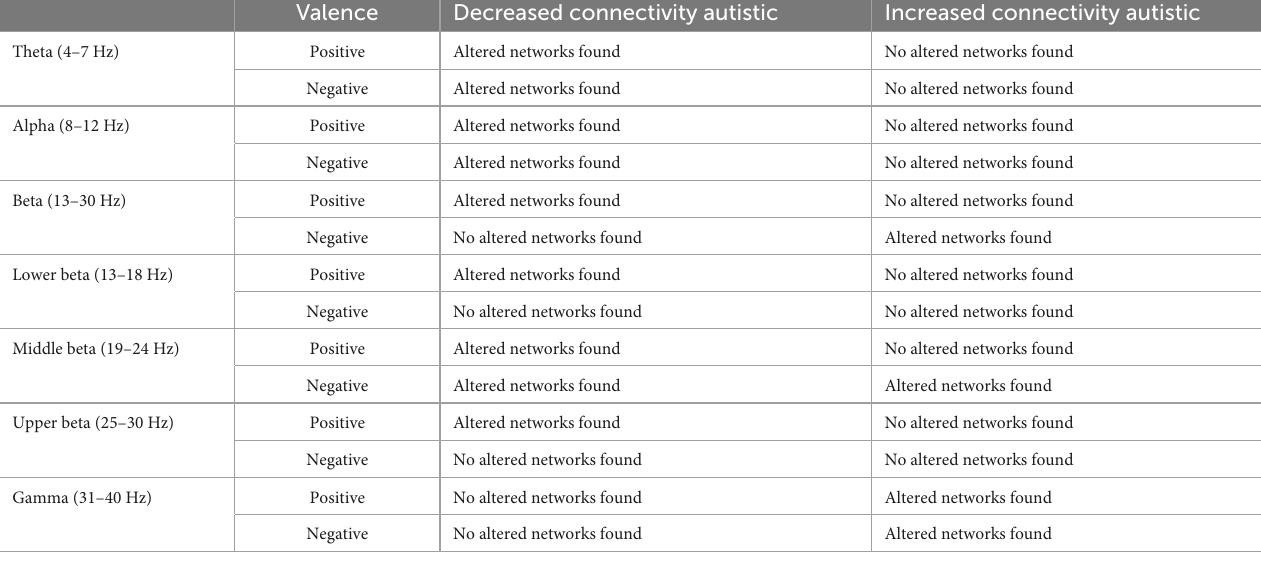
TABLE 2 Summary statistics of the identified networks with statistically significantly altered connectivity strengths identified in task 3.2 Investigation of Altered Functional